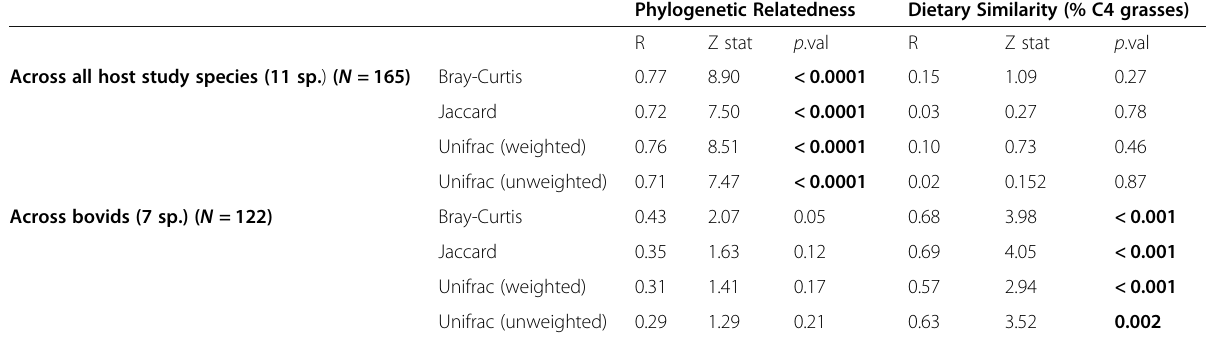
Table 2 The relative contributions of host phylogenetic relatedness and diet in predicting gut microbiota similarity Phylogenetic